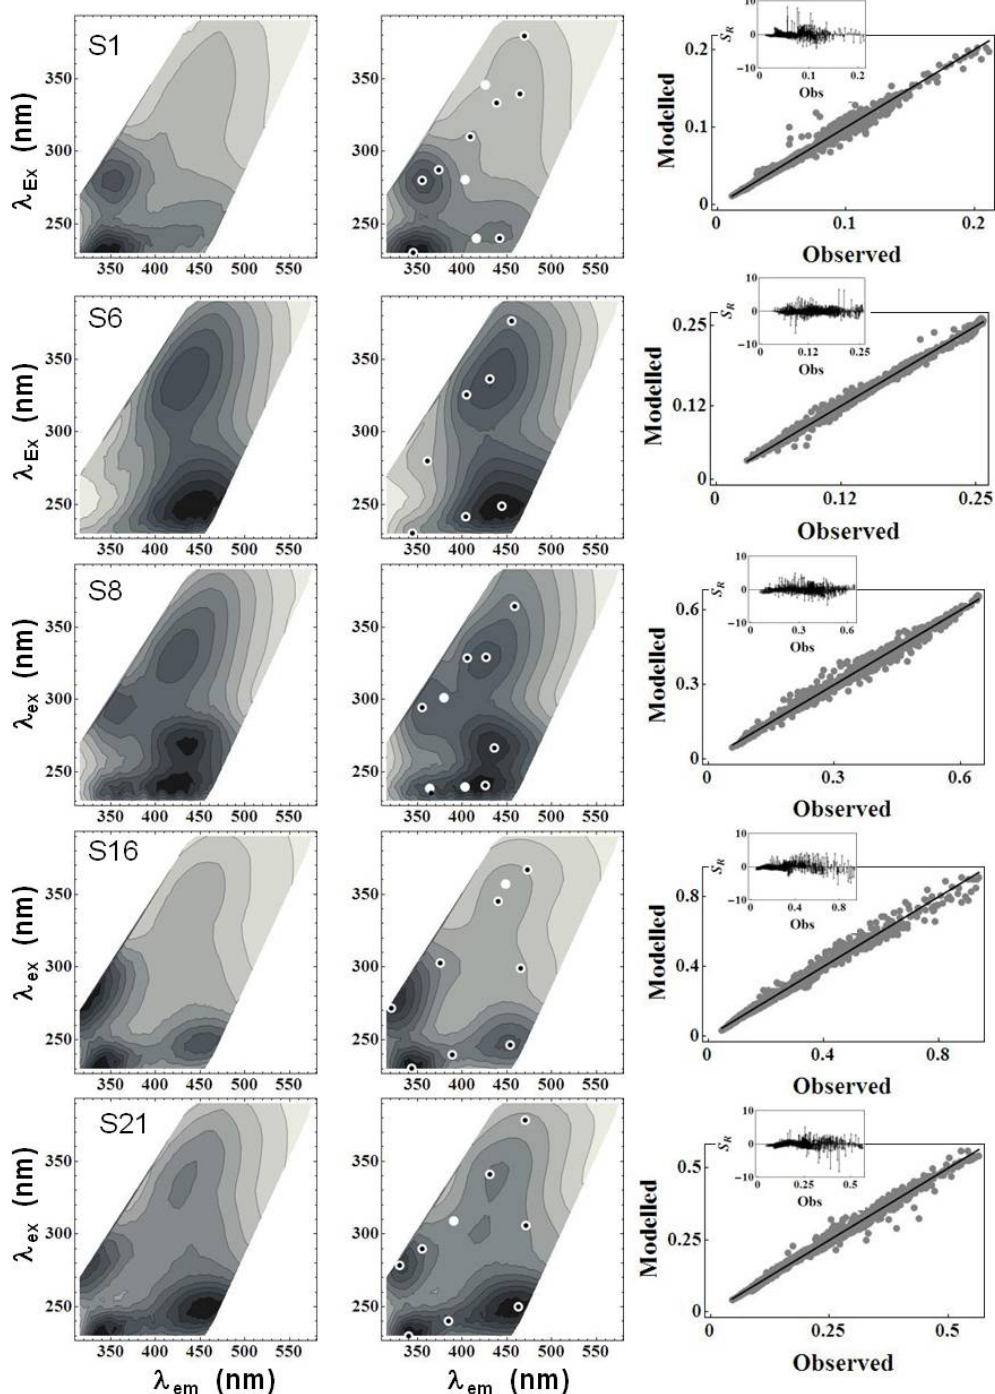
Fig. 6. Examples of observed (left) and modelled (center) EEMs from la Tordera river from five sampling sites. Each contour represents 10% of the total intensity. Large white and small black dots in contours plots show the location of potential and selected peaks respectively. Scatter plots on the right show the fit between modelled and observed EEMs (values in Raman units). Each dot represents a single fluorescence pair that compose the observed and modelled EEM. Solid line shows the 1 : 1 line. The inset shows the plot of standardized residuals (SR) respect to the observed (Obs)